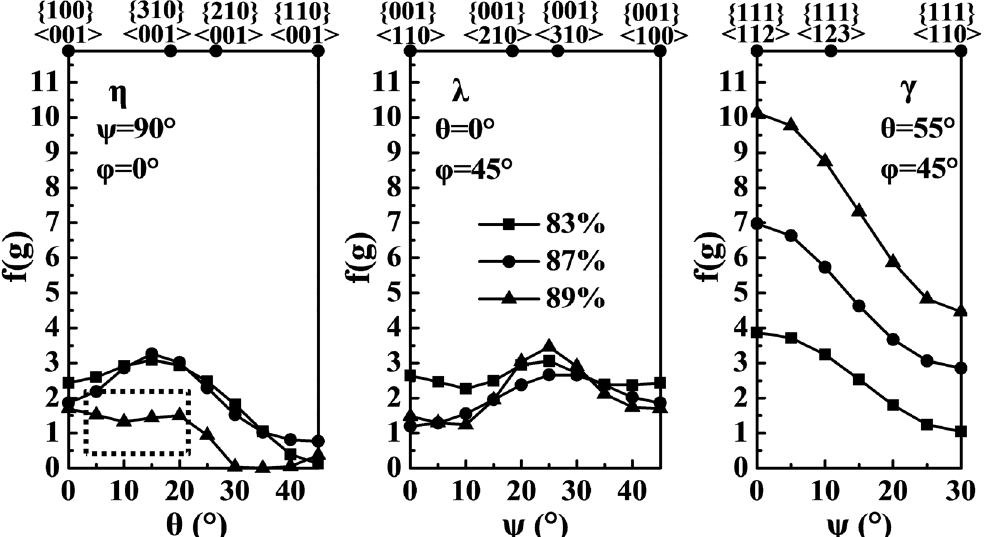
Figure 5. Orientation densities along η, λ and γ fibers in Fe-4.5 wt.% Si sheets after decarburization annealing at 830 °C for different reductions. various grain size ranges. It can be found that the fractions of η and λ increase sharply beyond the grain size of 25 μm, while γ has a much higher fraction in the range of 5-20 μm.